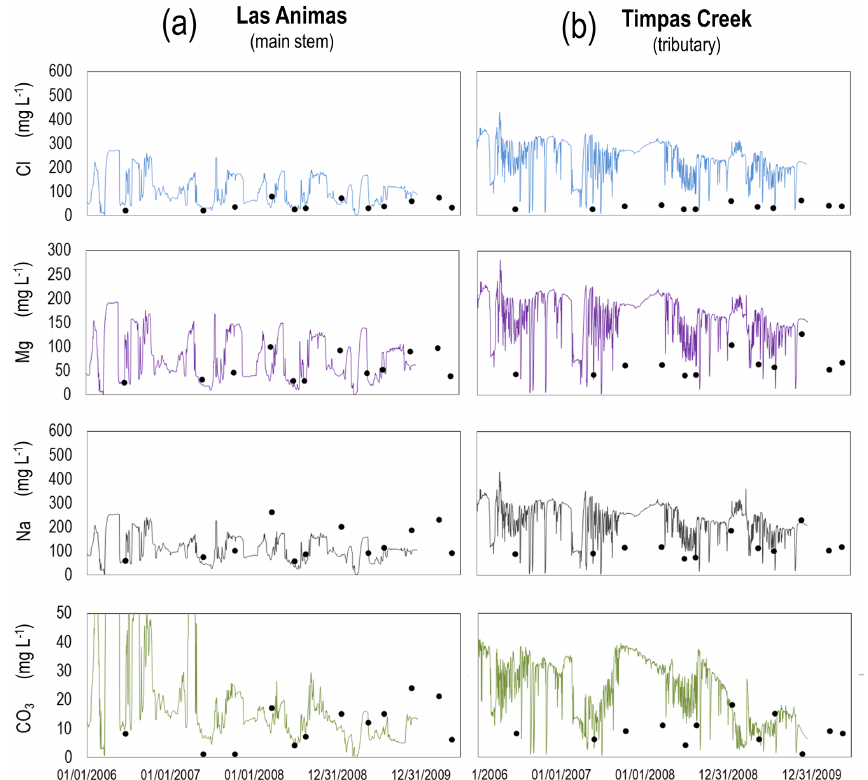
Figure 7. Time series of simulated and observed concentrations (mgL − 1 ) for each of the eight major salt ions for the (a) Las Animas site and (b) Timpas Creek site, for the model scenario of using 0.0002 soil bulk fractions for MgCO 3 , MgSO 4 , and NaCl. For the baseline model, these fractions were set to 0.00.